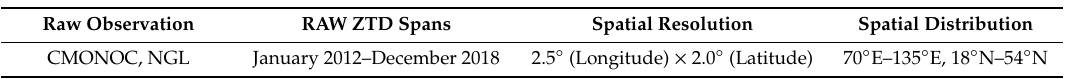
Table 2. Characteristics of the data used in this